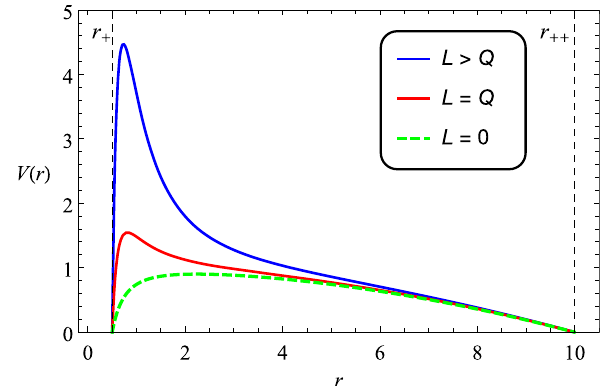
Fig. 2 The effective potential for test particles with angular momen- tum. Based on the values of E , several turning points (approaches) are available.Theseincludetheradiusofunstablecircularorbits r U ,andtwo other points, r P and r A . At these turning points, we have E 2 = V ( r t